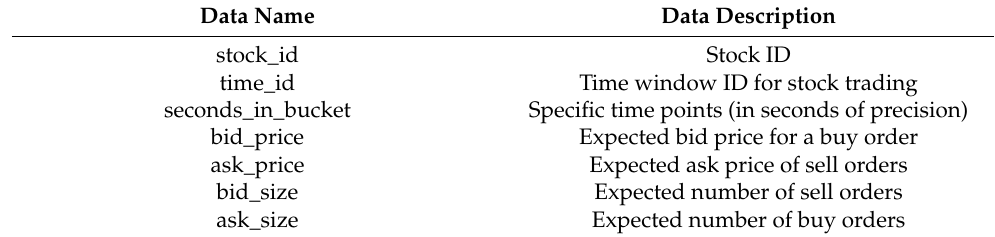
Table 1. Data Structure.